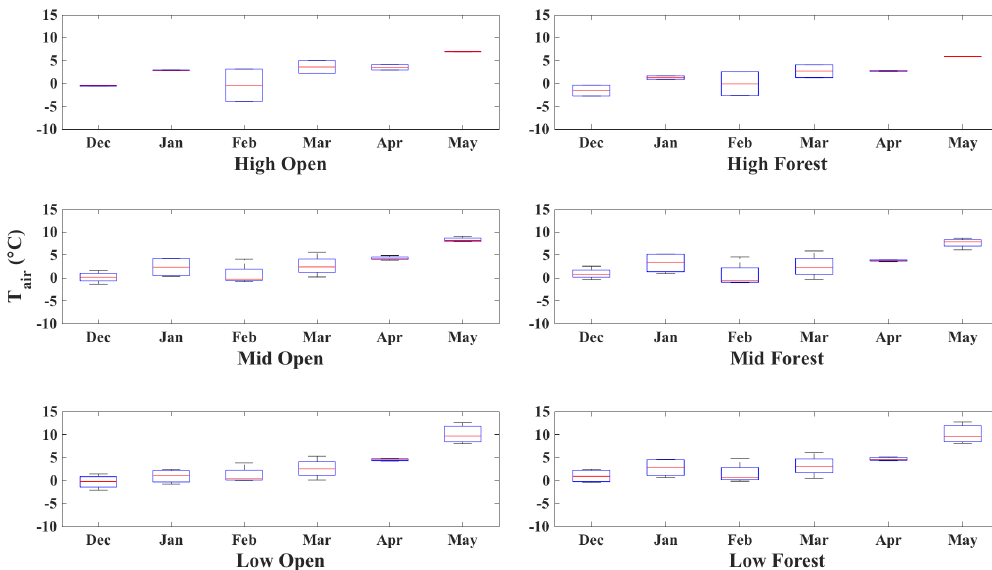
Figure 6. Boxplot of average monthly air temperature for each site within the ForEST network, WY 2012–WY 2015.